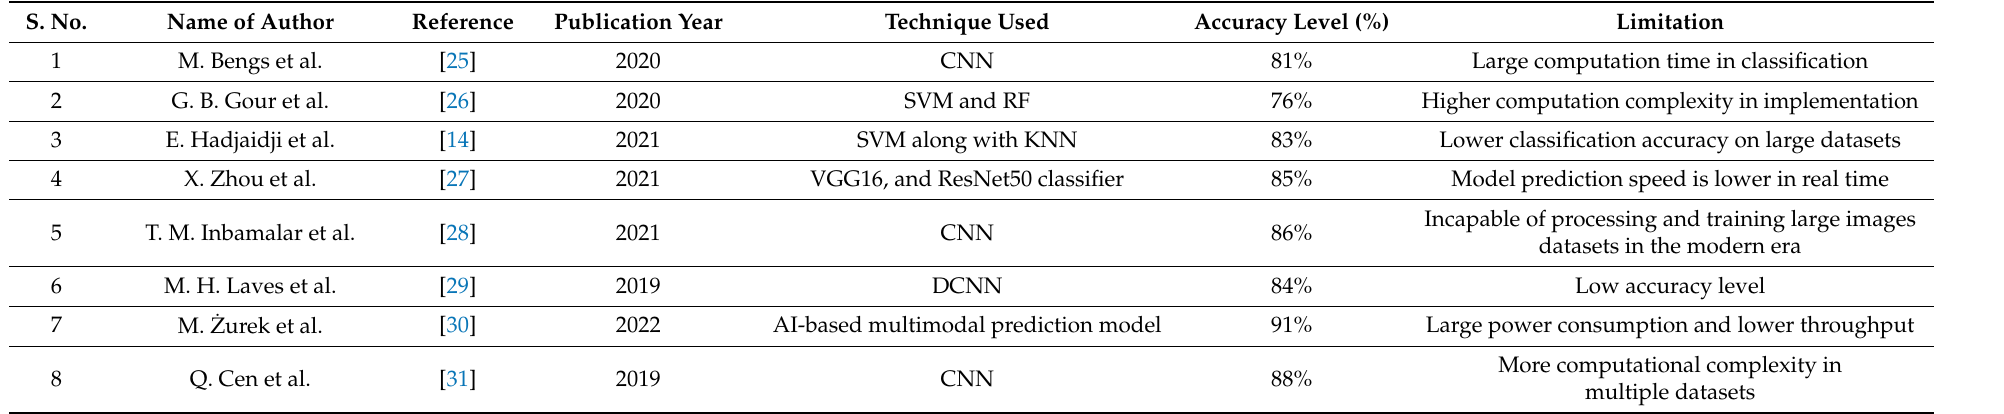
Table 1. Existing work conducted on laryngeal cancer detection